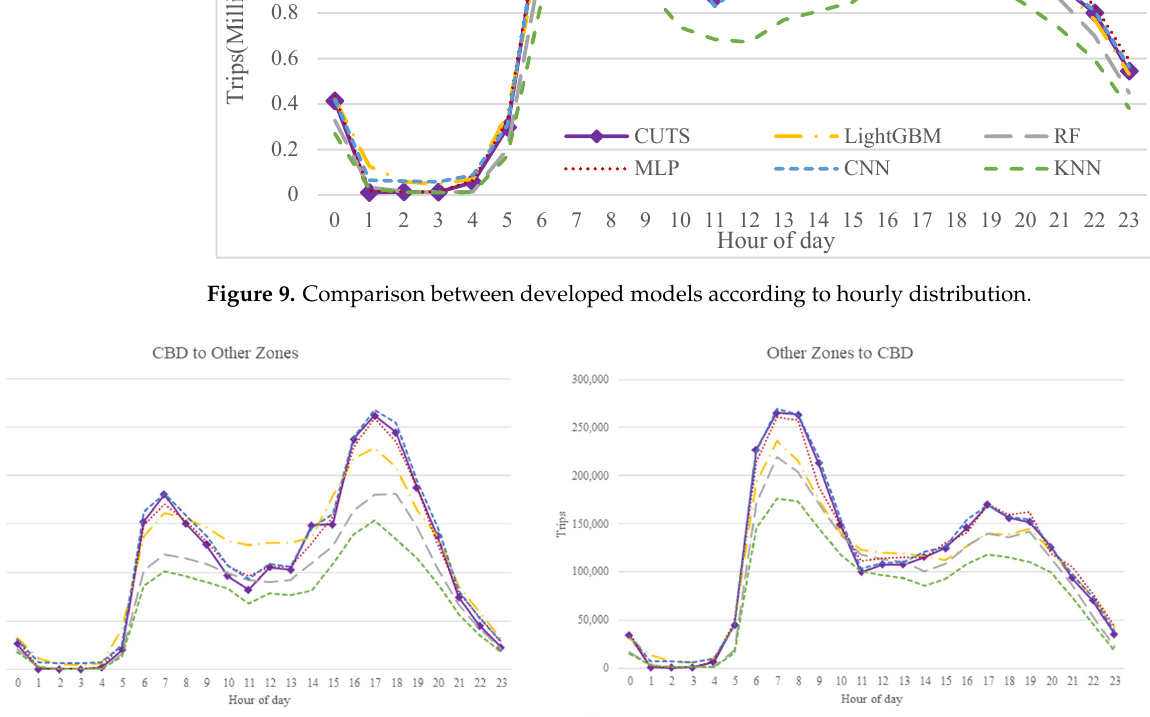
Sensors 2021 , 21 , x FOR PEER REVIEW 15 of 19